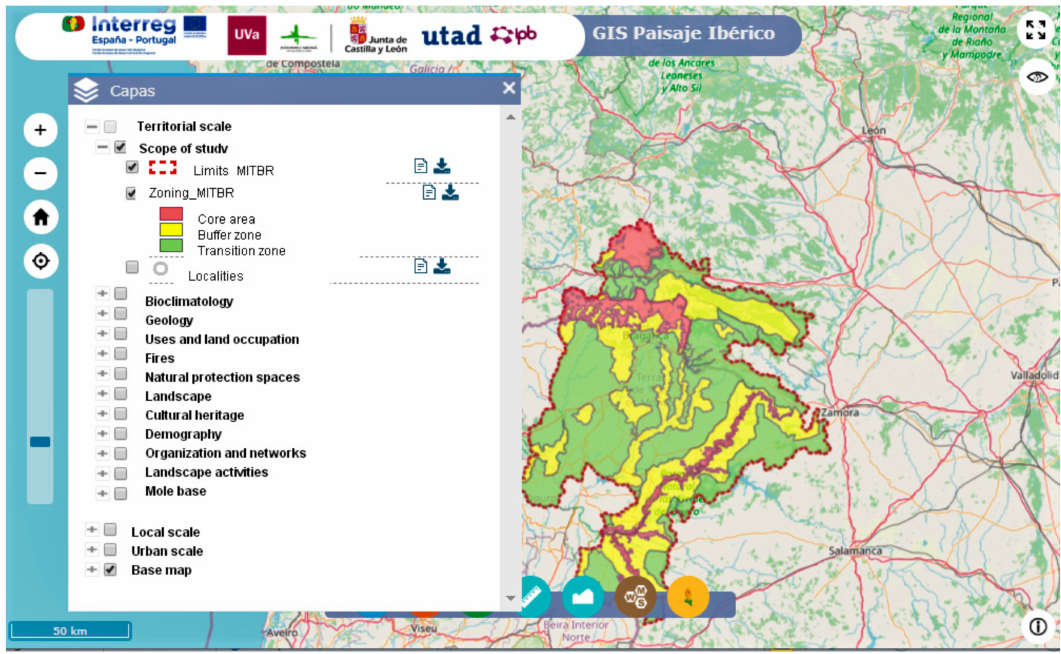
Figure 2. Thematic groups displayed on the MITBR geoportal